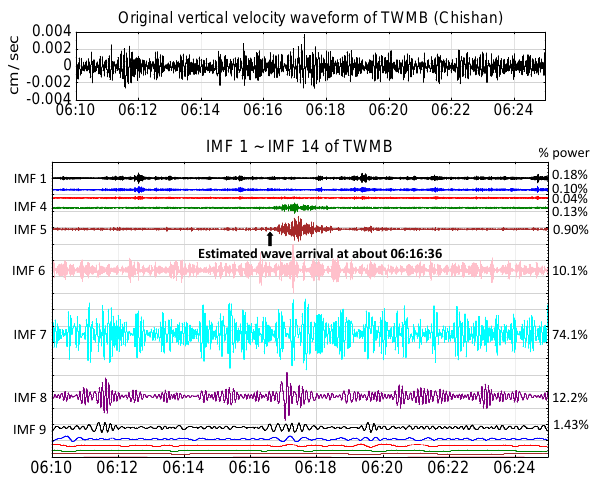
Figure 10 IMFs 1 – 14 of the vertical velocity from the TWMB station (06:10 to Fig. 10. IMFs 1–14 of the vertical velocity from the TWMB station 06:25, August 9, 2009). (06:10 to 06:25a.m.LT, 9 August 2009).